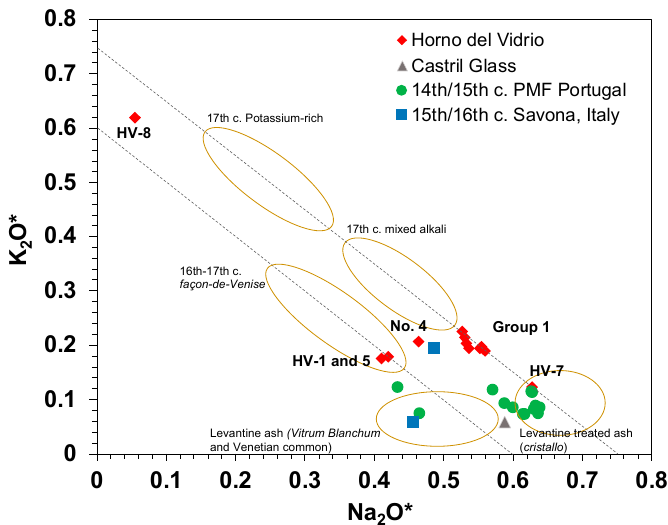
Figure 4. Binary plot of Na 2 O* vs. K 2 O*. Na 2 O* and K 2 O* values are obtained through the division of the respective oxide by every component introduced by the ash (Na 2 O, MgO, P 2 O 5 , K 2 O and CaO). The two correlation lines represent the purified ash (Na 2 O* + K 2 O* = 0.75) and the unpurified ash (Na 2 O* + K 2 O* = 0.6) [46]. Samples from the Horno del Vidrio were plotted together with Castril glass [13], 14th/15th century PMF samples [17] and 15th/16th century glass from Savona, Italy